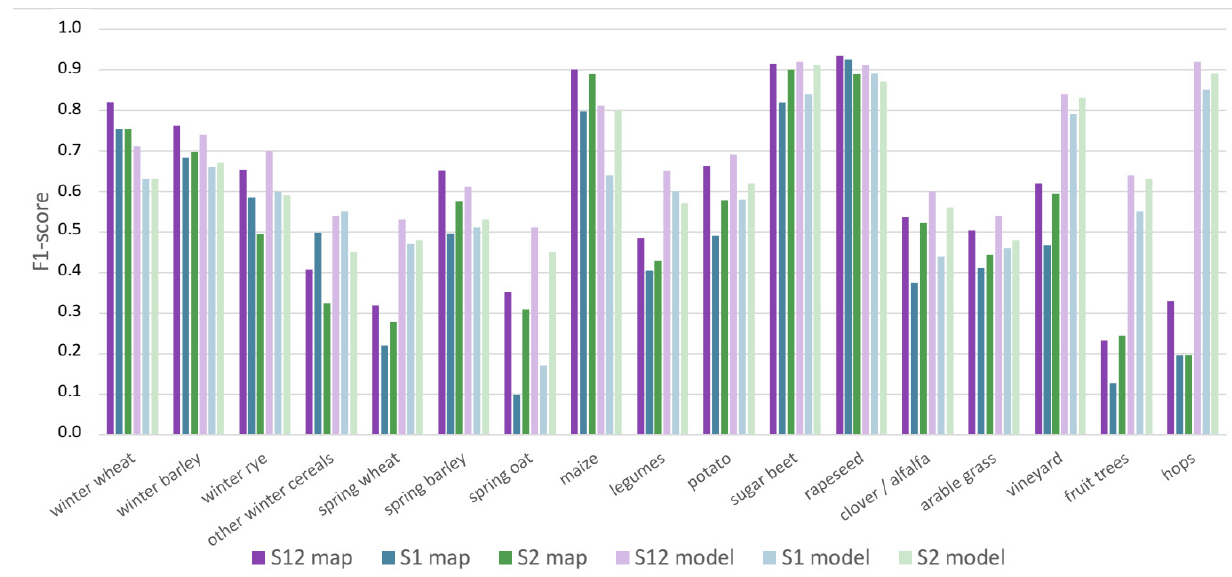
Figure 4. Class-specific map (dark colors) and model (light colors) accuracies achieved for classifications with combined use of Sentinel-1 and Sentinel-2 data (violet), of only Sentinel-1 data (blue), and of only Sentinel-2 data (green).